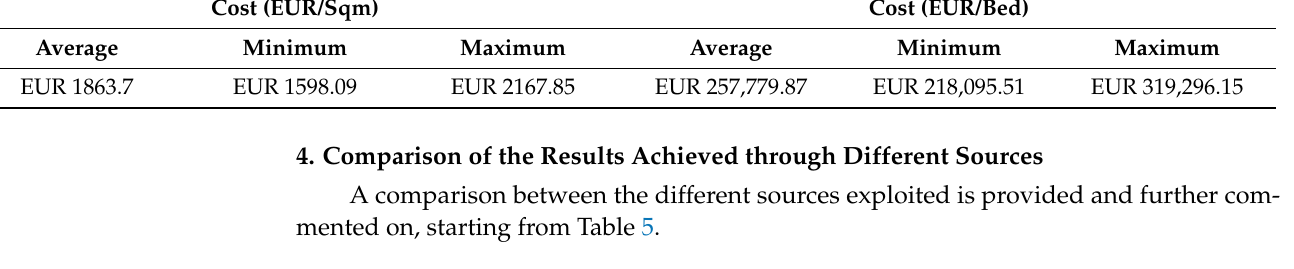
Table 5. Construction cost comparative